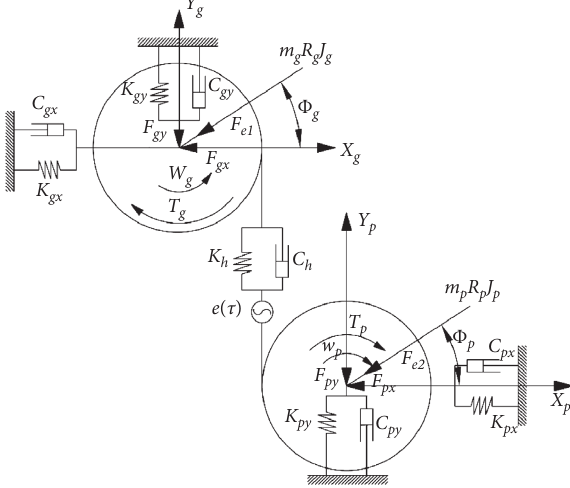
Figure 4: Dynamic model of gear transmission